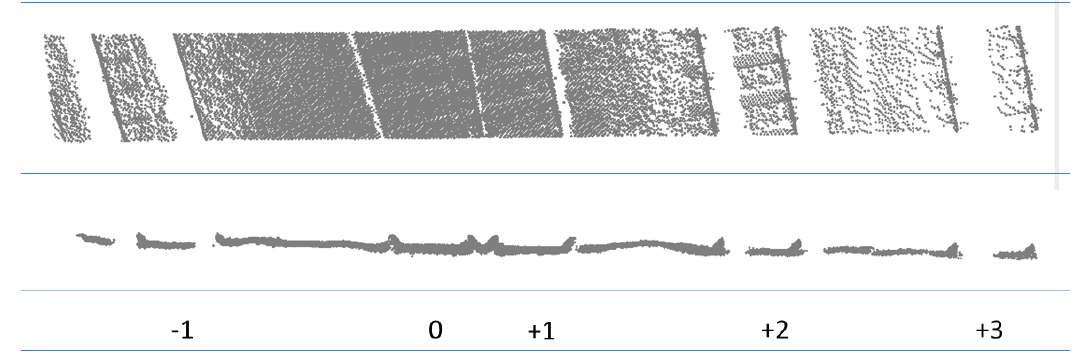
Figure 1. Varying point density across neighboring rail tracks. Top view ( top ), cross section ( middle ), and rail track number ( bottom ). The mobile mapping system was mounted on a platform driving at track “0”. It is our aim to find the centerlines of all